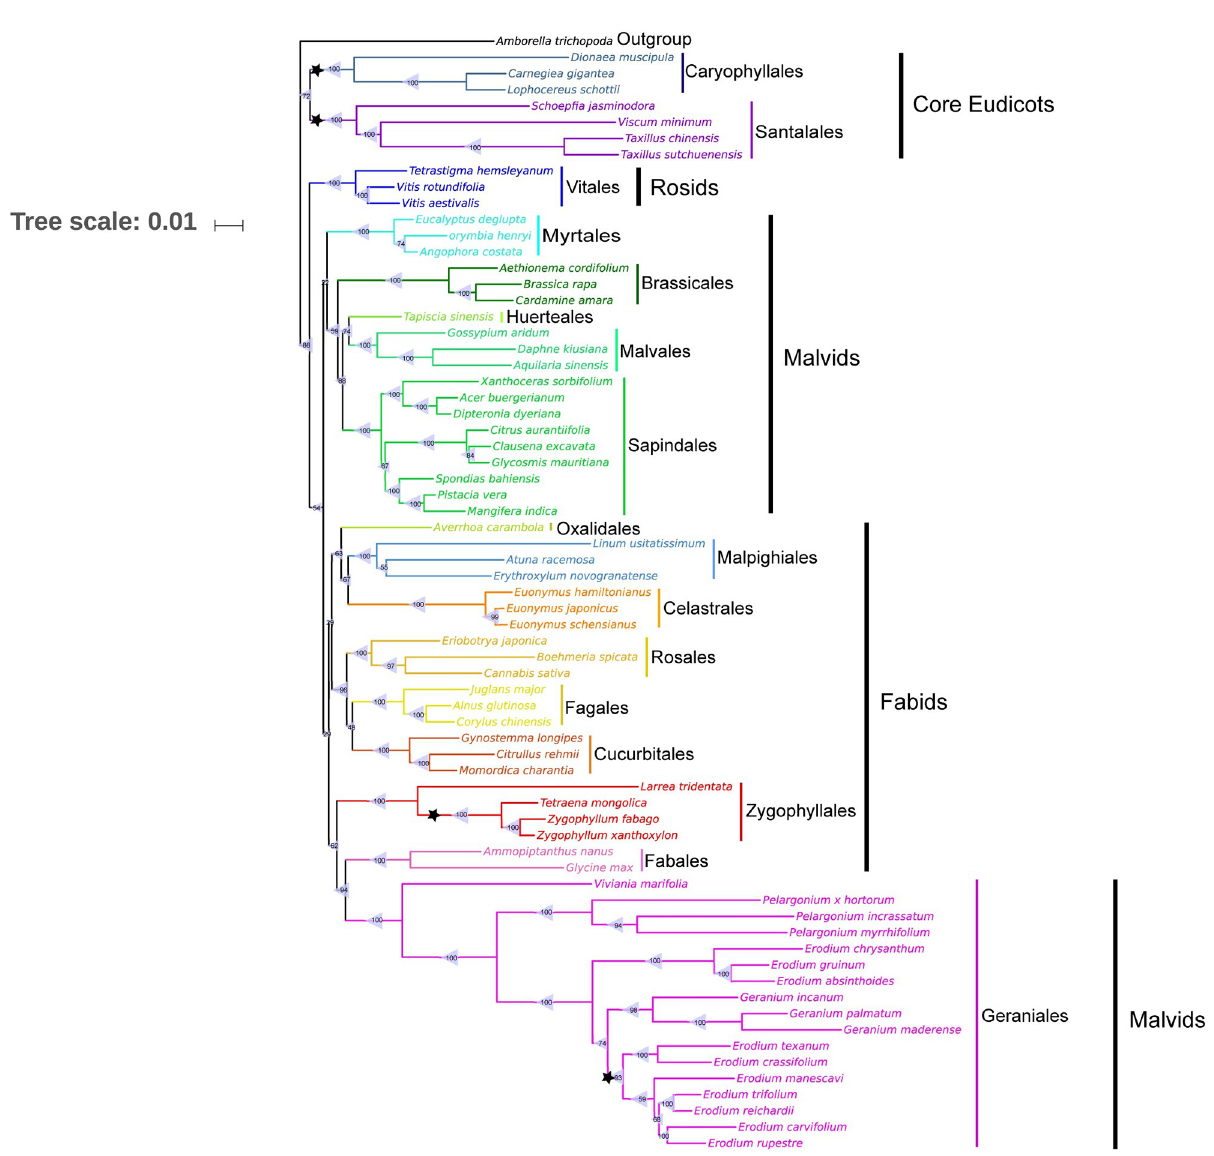
Fig 9. The phylogenetic tree of the sequences from 69 species, using Maximum Likelihood (ML) based on concatenated sequences of 50 genes implemented in MEGA X. A . trichopoda was set as the outgroup. Bootstrap supports were calculated from 1000 replicates. ▲ Represent the bootstrap value. $ Represent the missing evolutionary branch of the 11